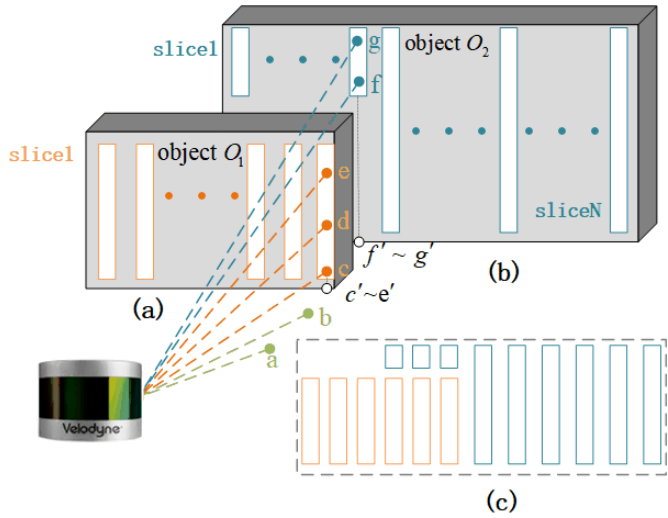
Figure 3. The schematic diagram of a LiDAR slice. ( a ) Points and slices within object O 1 . ( b ) Points and slices within object O 2 . ( c ) Slices and objects within a vertical plane.